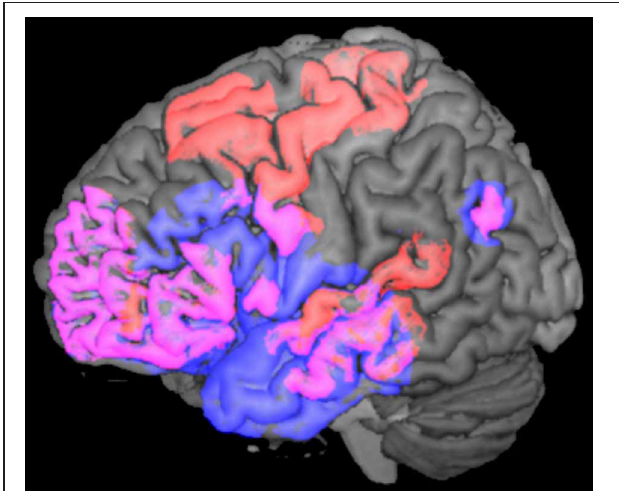
FIGURE 5 | N400 brain activations for words and actions. Lateral view of the left hemisphere showing the N400 neural sources for words (in blue) and for actions (in red). The figure was computed using the MRIcron software (Rorden and Brett, 2000) and the spherical regions of interest ( ROIs ) ( 5mm ) displayed in the picture were taken from the MEG, fMRI, ERP, and intracranial studies reviewed in this article (please see Halgren et al., 2002; Proverbio et al., 2010; Ibáñez et al., 2012a). Please note that overlapping activations (in pink) in frontal, temporal, and parietal areas are common to both N400s, while motor and premotor regions are activated only during the processing of action-related